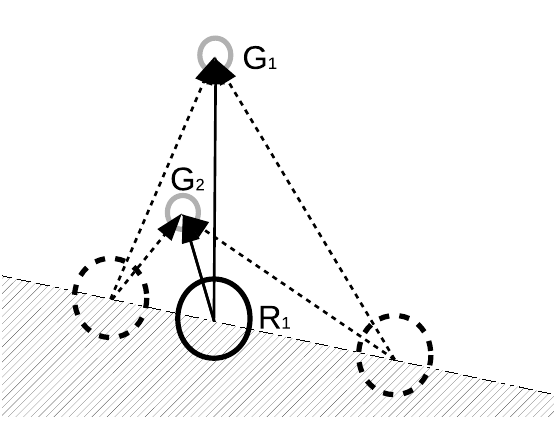
Figure 11. Two robot-goal assignment—case